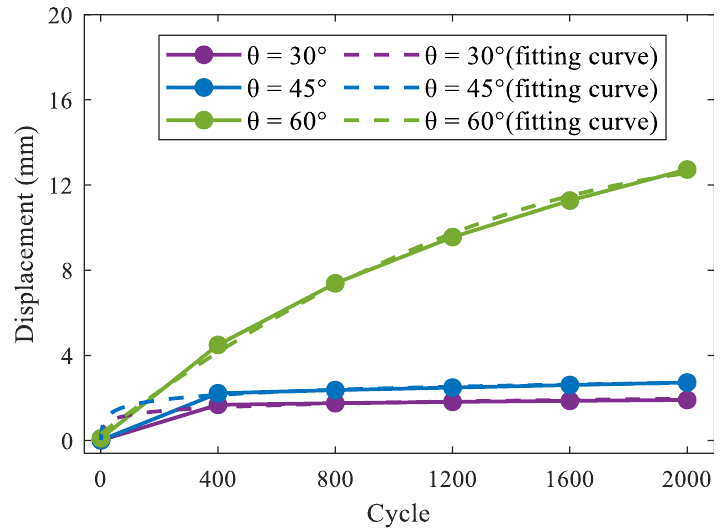
Figure 10. Cycle times – cumulative displacement relationship for variable initial tension angles. Figure 9. Deformation of anchor piles under oblique loading: ( a ) before deflection, ( b ) after deflection.